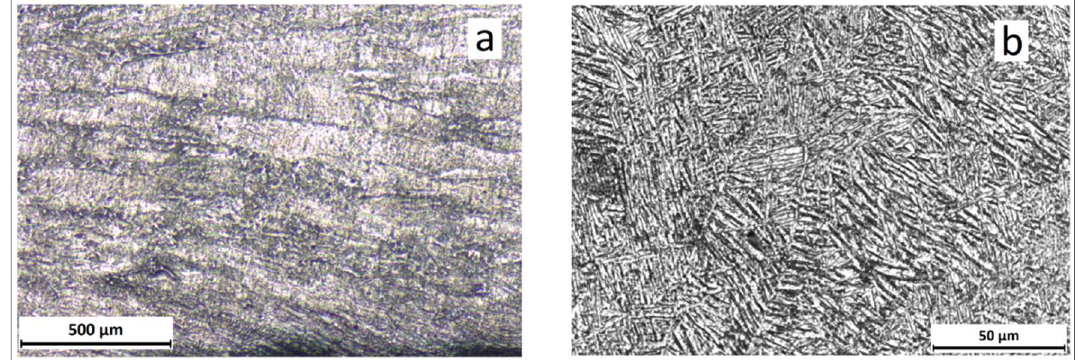
Figure 10. Optical micrographs performed on the cross section (specimen A): ( a ) Low magnification; ( b ) High magnification.